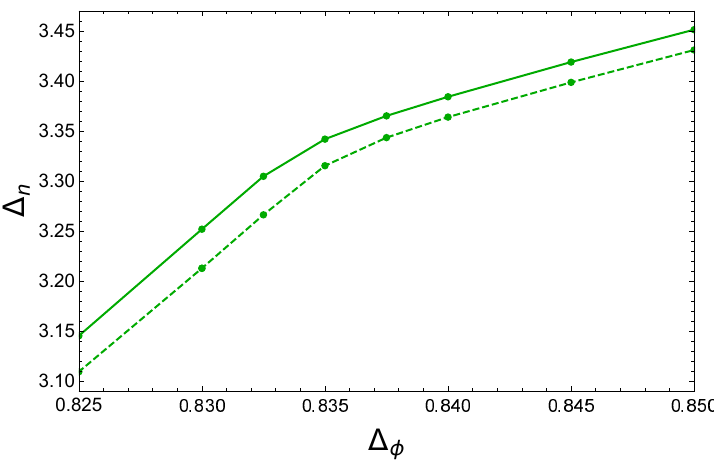
Figure 5 . Numerical bootstrap bound on the scaling dimension of the first n-channel scalar operator in CFTs with S 10 Z 2 symmetry. The solid line corresponds to bounds without a spin-2 gap, while ⊗ the dashed shows the result when a small gap for the spin-2 operator in the S -channel is